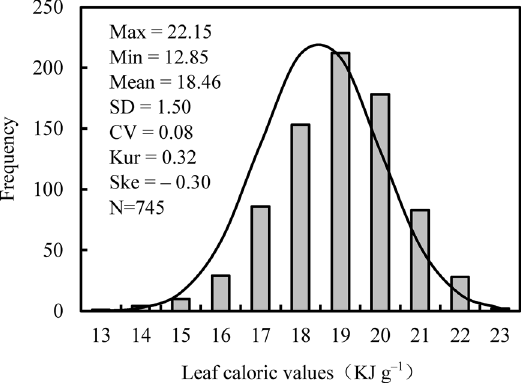
Fig 1. Frequency distribution of leaf caloric values in Chinese